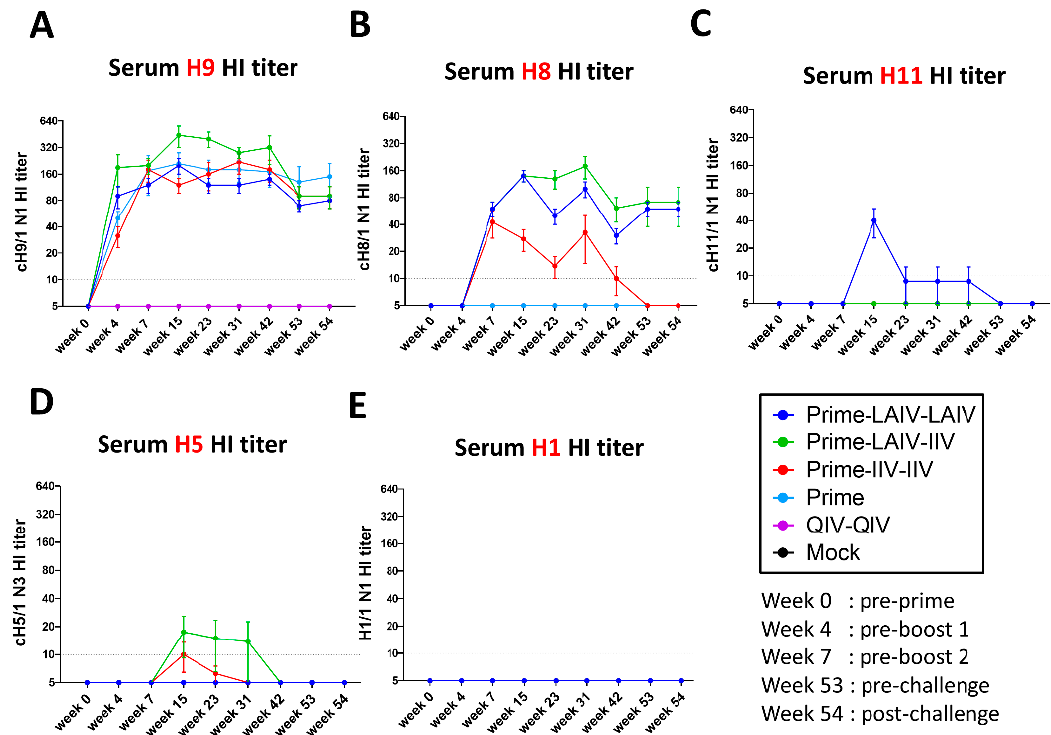
Figure 2. Kinetics of vaccine-specific antibody responses measured by hemagglutination inhibition assay. Hemagglutination inhibition (HI) titers against ( A ) cH9/1, ( B ) cH8/1, ( C ) cH11/1, ( D ) cH5/1 and ( E ) pH1N1 viruses were measured at the indicated time points prior to and following pH1N1 influenza A virus challenge infection. Each y-axis indicates the HI titers against the indicated virus strain. Prime-LAIV-LAIV, Prime-LAIV-IIV, Prime-IIV-IIV, Prime, QIV-QIV, and Mock vaccinated animals are shown as dark blue, green, red, light blue, purple, and black lines, respectively. Mean HI titers ± standard error of the mean (SEM) against the vaccinated virus strains at indicated time points are indicated ( n = 4 ferrets per group). The black dashed line indicates the limit of detection for the assay.